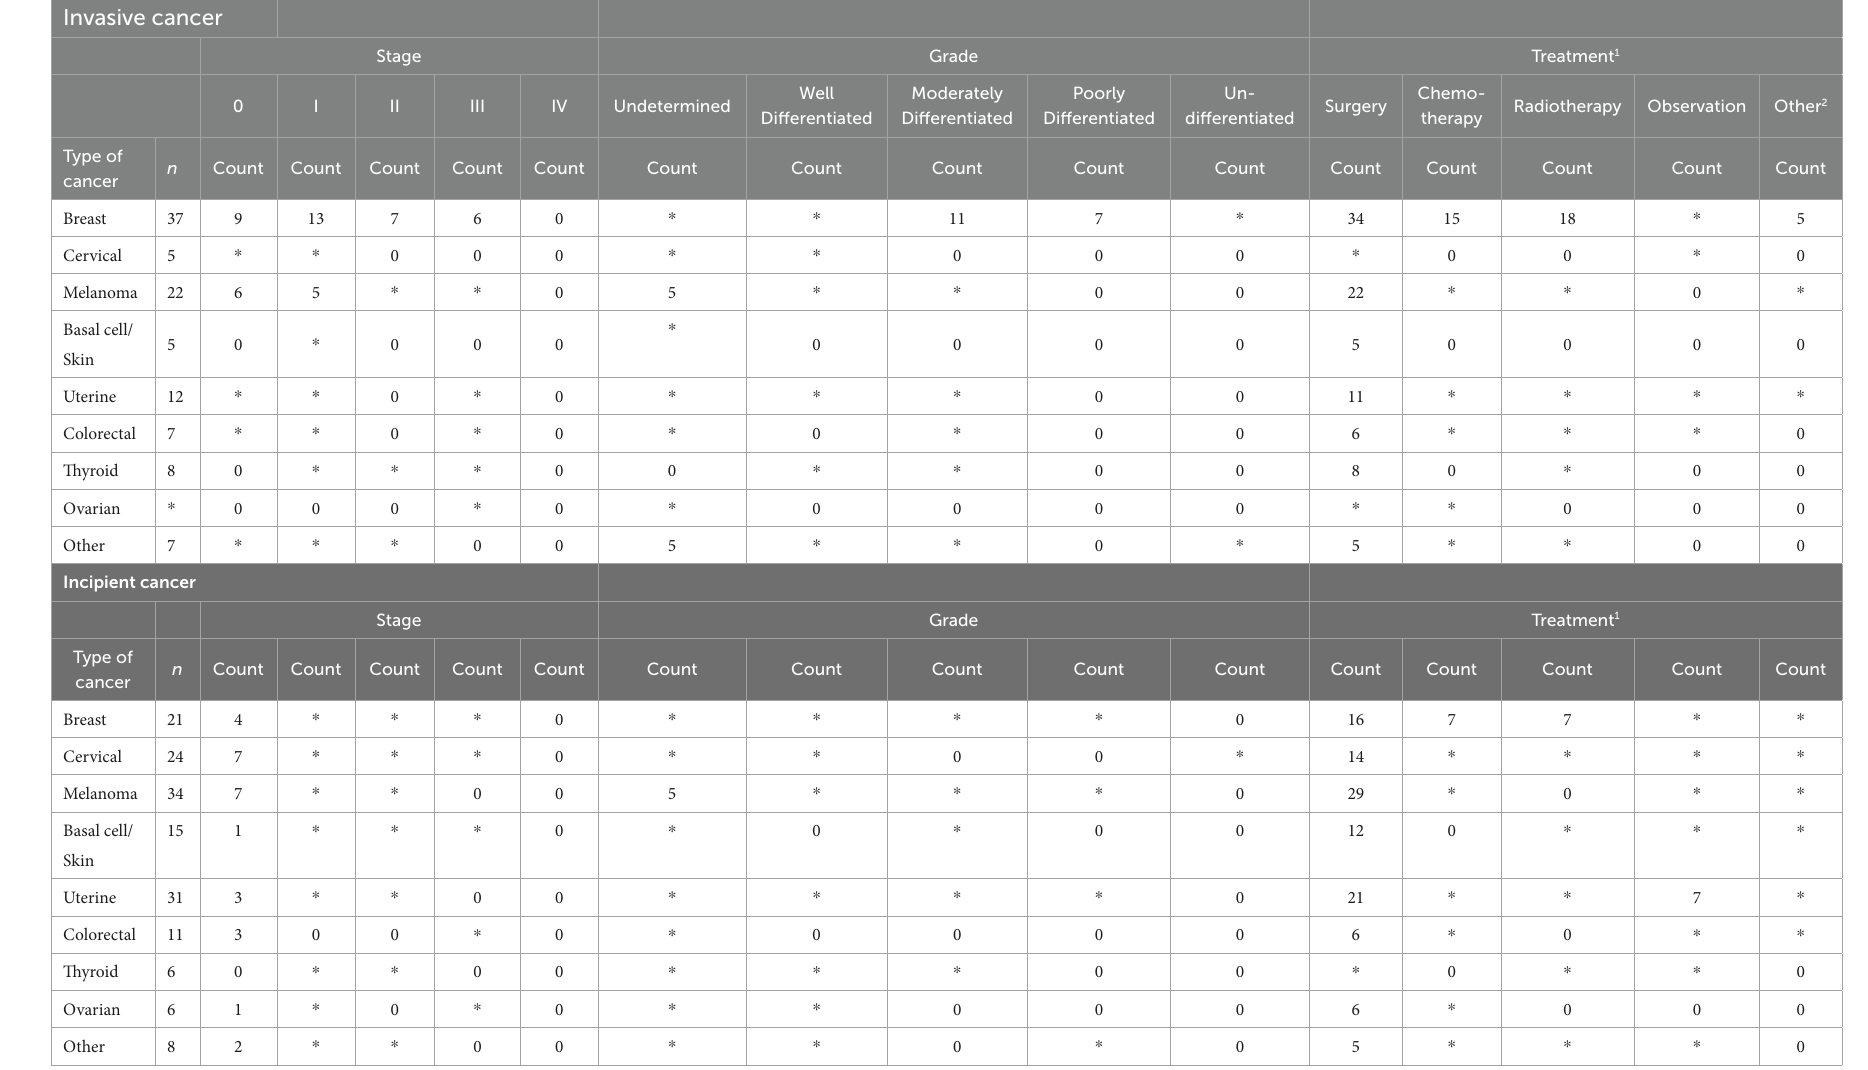
TABLE 5 Cancers experienced by female firefighter survey respondents, with invasive cancer or incipient cancer, by stage, grade, and treatment type. Invasive cancer